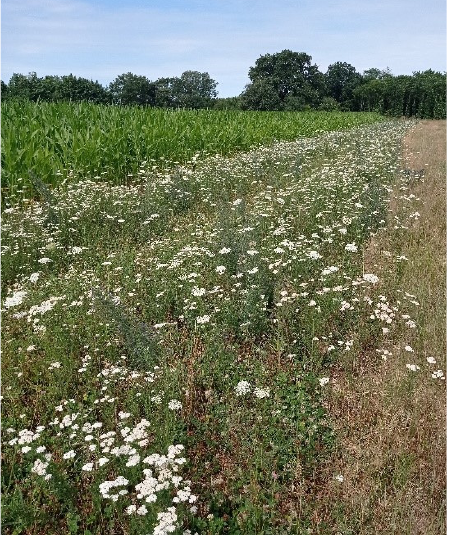
Figure 3. A 6 m flower strip with high plants surrounded by sweet corn cultivation, luring beneficial insects (mid-July 2022, authors’ observations in the National Park of Greater Poland). insects (mid-July 2022, authors’ observations in the National Park of Greater